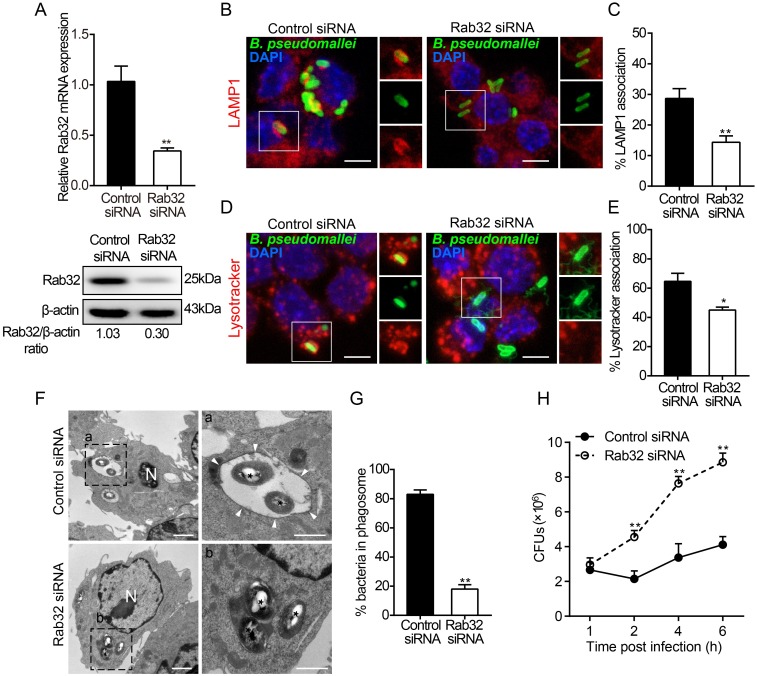
Rab32-positive phagosomes were recruited to limit the growth of B. pseudomallei.(A) The relative mRNA or protein concentrations of Rab32 were measured in RAW264.7 cells after transfection with 100 nM Rab32 specific siRNA or control RNA for 24 h. (B and C) Representative images of control and Rab32 silenced cells were infected with B. pseudomallei for 2 h, and stained with anti-LAMP1 antibody (red), or anti-B. pseudomallei antibody (green) or DAPI (blue). Quantitative analysis of LAMP1 fluorescence intensity associated with B. pseudomallei phagosomes. Scale bar is 5 μm. (D and E) Association of LAMP2 with B. pseudomallei as in B and a quantitative analysis of LAMP2 association with B. pseudomallei phagosomes as in C. Scale bar is 5 μm. (F) Representative TEM images of control and Rab32 silenced RAW264.7 cells infected with B. pseudomallei (asterisks) for 2 h showing differences in the intracellular location of B. pseudomallei. (white arrowheads = phagosome membrane; N = nucleus). Scale bar is 5 μm. (G) Quantitative analysis of bacteria associated with single-membrane phagosomes. At least 150 bacteria were quantified. (H) Intracellular B. pseudomallei burdens in Rab32 silenced and control RAW264.7 cells at the indicated times after infection. Data is shown as the mean ± SD of three independent experiments. *P<0.05, **P<0.01.